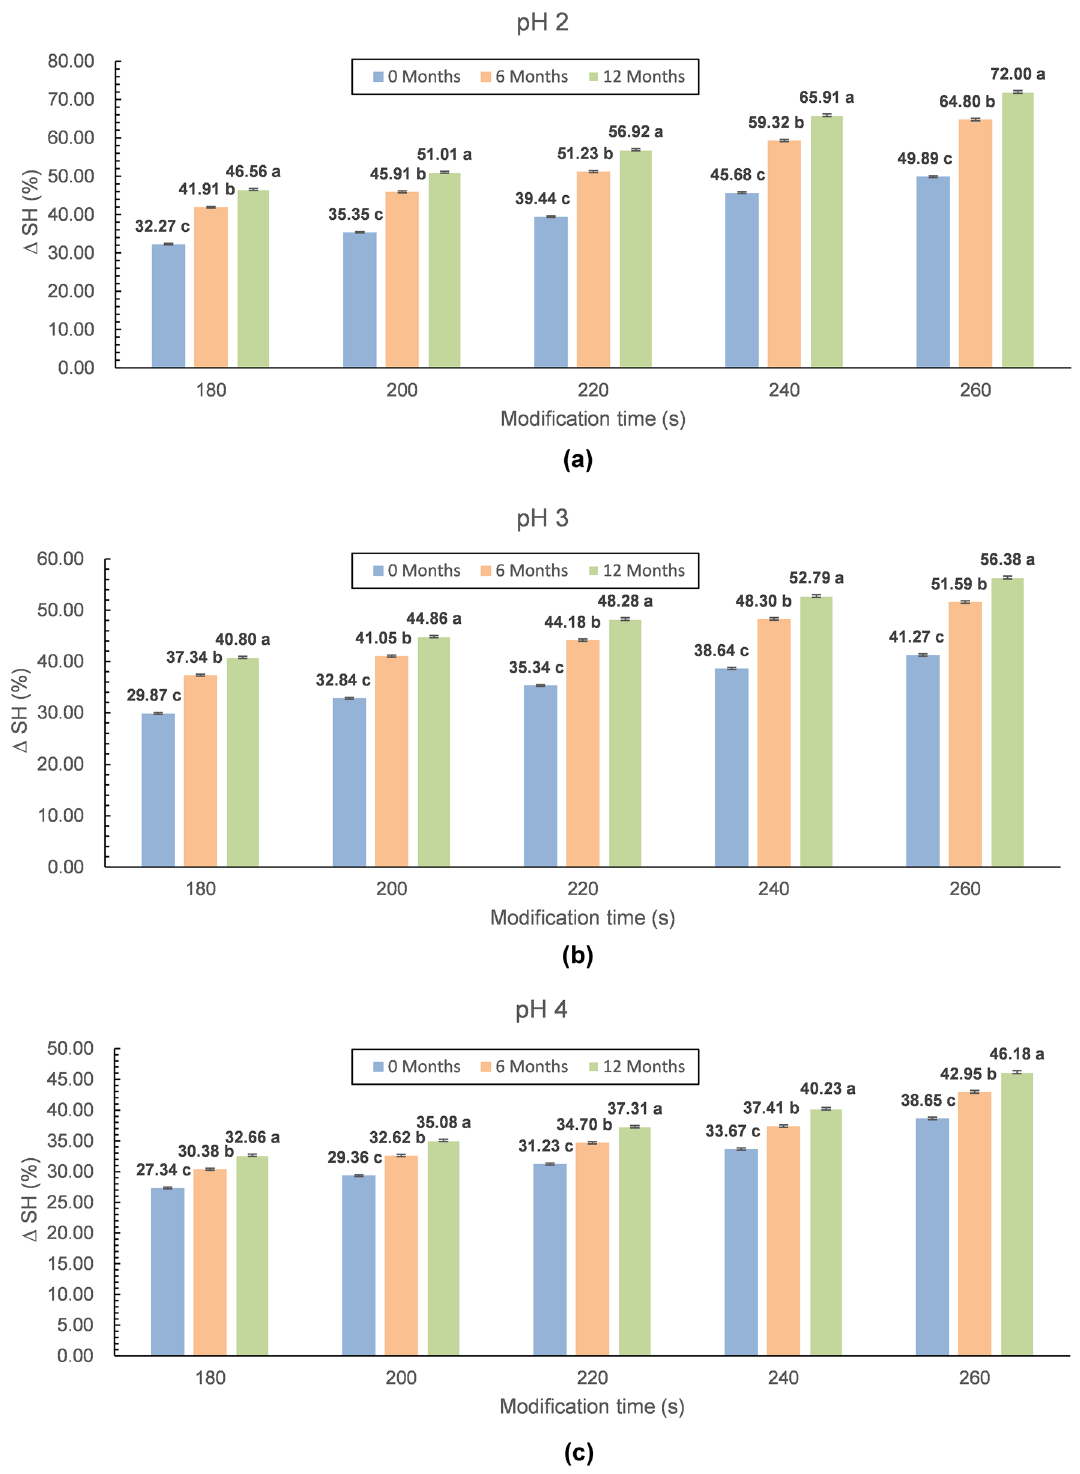
Figure 4. Graphical interpretation of the storage changes of the hydrophobic surface of microwave-modified lysozyme preparations ( a —pH 2, b —pH 3, c —pH 4). Storage times: 0, 6, and 12 months. Time of modification: 180, 200, 220, 240, and 260 s. ( a–c Different letters on the bars denote a significant difference in the means at p ≤ 0.05—separately considered for each modification